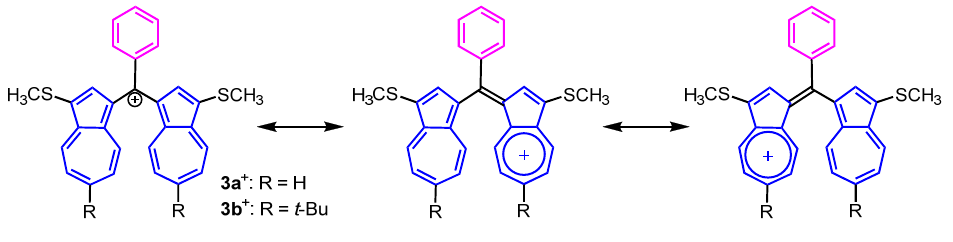
Figure 4. Plausible resonance structures of 3a , b + ·PF 6 − .